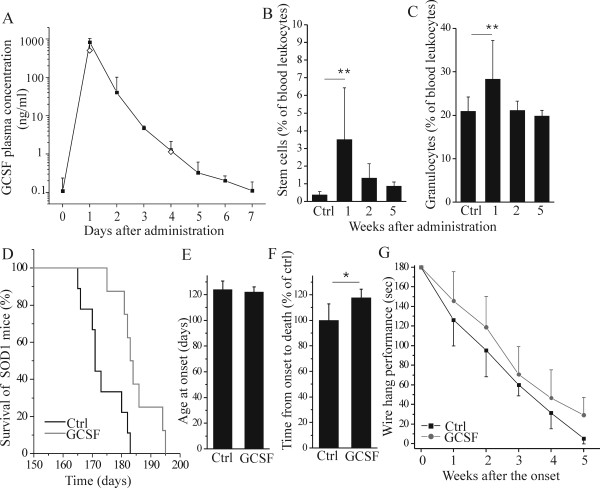
GCSF with sustained activity has biological efficacy and prolongs the survival of mutant SOD1 mice. Mutant SOD1 mice were treated with pegfilgrastim once a week starting at the age of 12 weeks. Plasma concentration of GCSF remained elevated multiple days after a single injection of 300 μg/kg (A) but returned back to baseline at day 7 before the next dosage (data was obtained from 33 mice, 1-2 blood samples/mouse). This occurred in a similar manner after the first dosage (A, open squares) as well as after the long-term pegfilgrastim treatment (A, black squares). Pegfilgrastim elevated the levels of stem cells (B, p <0.01, n = 11) and granulocytes (C, p <0.01, n = 11) after the first dosage, as analyzed four days after the pegfilgrastim administration, but the mobilization was decreased after prolonged pegfilgrastim treatment (n = 5). Long-term pegfilgrastim treatment increased the survival of mutant SOD1 mice as shown with a Kaplan-Meier survival graph (D, p <0.01, n = 8-9). Pegfilgrastim treatment did not delay the onset of the disease as determined by wire-hang test (E, n = 6) but increased the time from the onset to death (F, p <0.05, n = 4-5). The prolonged survival was accompanied with improved motoric performance in wire-hang test (G, p <0.05, n = 6) when analyzed within 5 weeks after the onset. The first mice died 5 weeks after the onset.